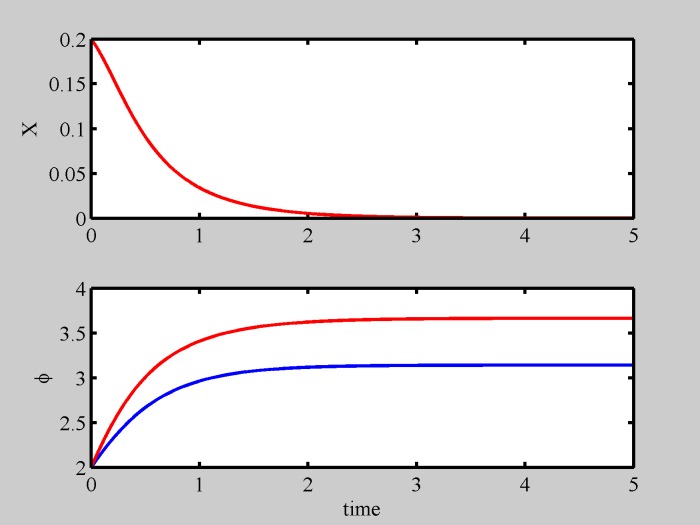
Two particles synchronization dynamics.Relative position dynamics (upper panel) and relative phase dynamics (lower panel) for a two particle system with no diversity (blue) and low diversity (Δ = 0.5, red) and different polarity (γ = −1). Particles glue together in an out-of-phase synchronization. Since identical starting conditions have been selected (x = 0.2, ϕ = 2), in the upper panel the curves are perfectly superposed.